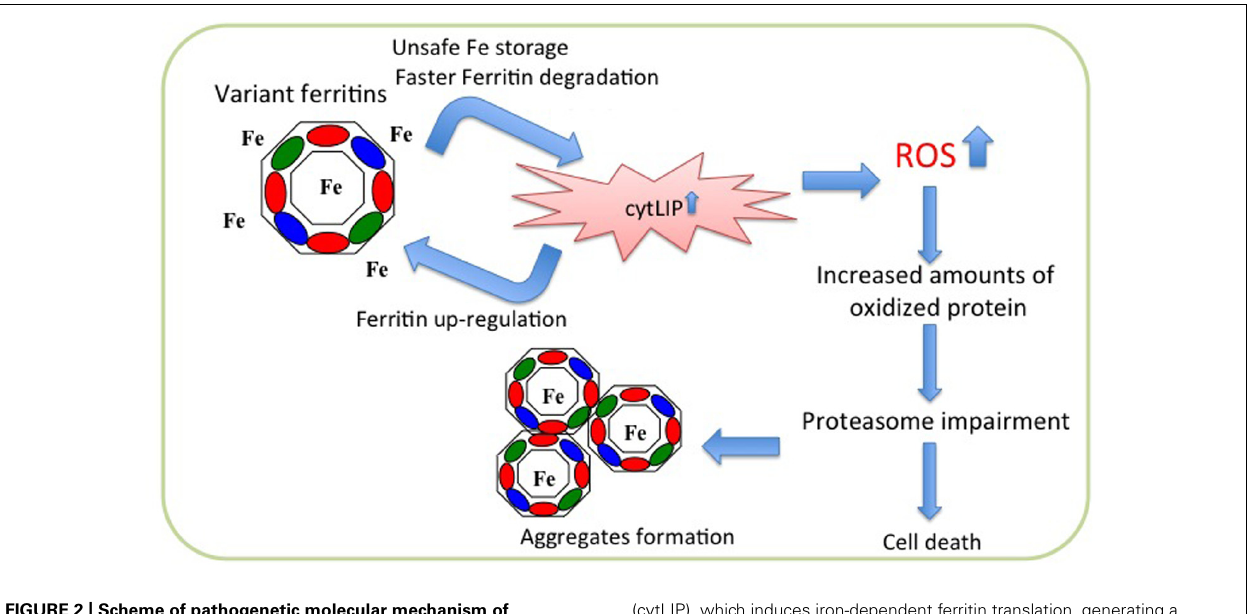
FIGURE 2 | Scheme of pathogenetic molecular mechanism of neuroferritinopathy. The mutated peptide (green ellipse) assembles with the H- (red ellipse) and L- (blue ellipse) subunits to form ferritin shell, which is unable to incorporate iron properly.This leads to iron excess in the cytosol